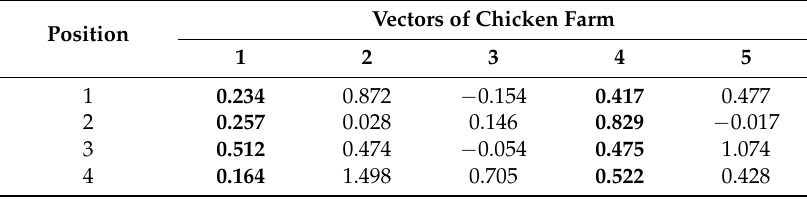
Table 14. Vectors after mutation of vector positions of chicken